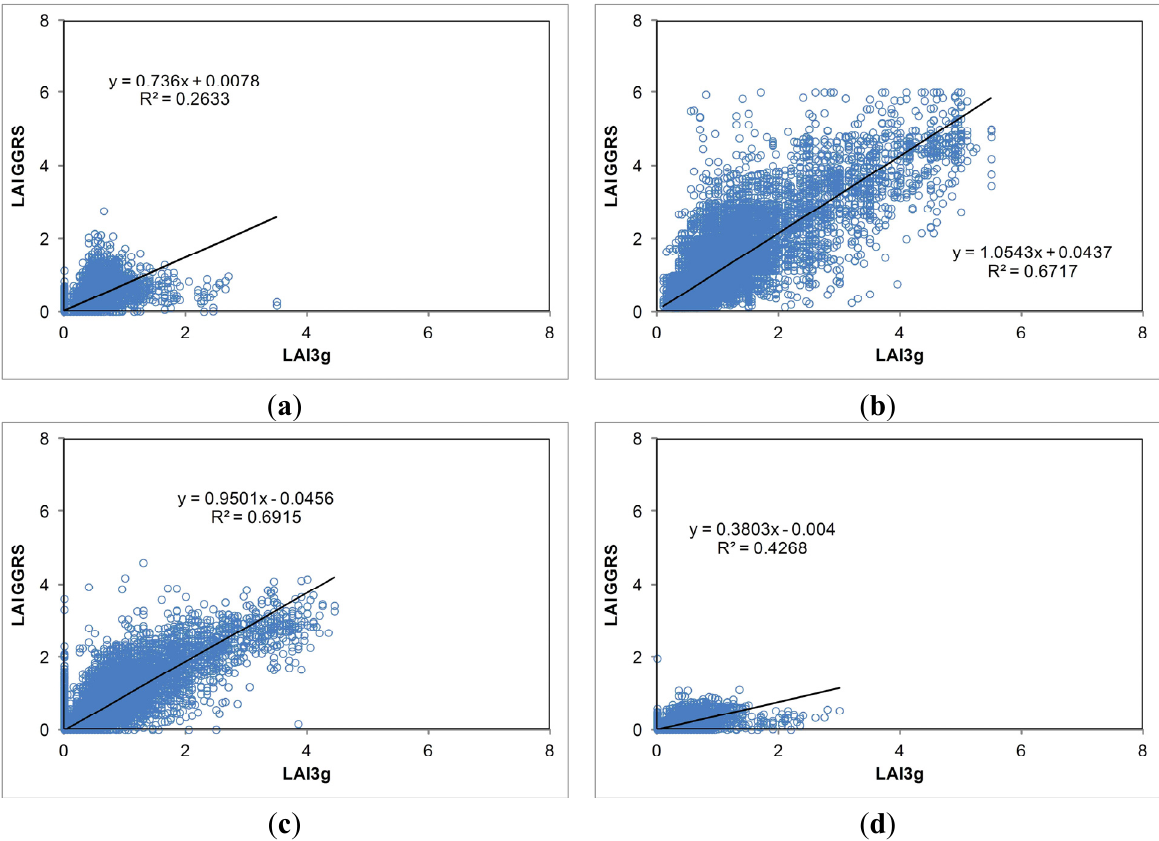
Figure 6. Comparison of LAI3g and LAI GGRS over the whole area of Kazakhstan for specific months in 2008: ( a ) April; ( b ) June; ( c ) August; and ( d ) October. Number of samples: